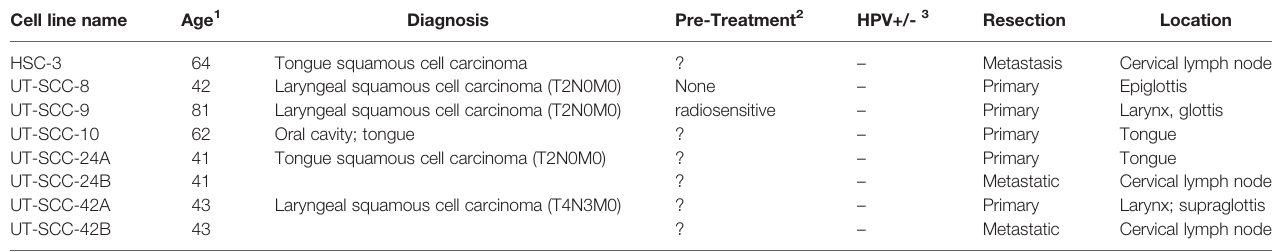
TABLE 1 | Head and neck cell line